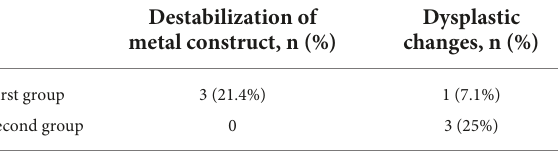
TABLE 4 Short-term and long-term results of surgical treatment of congenital spinal deformity.